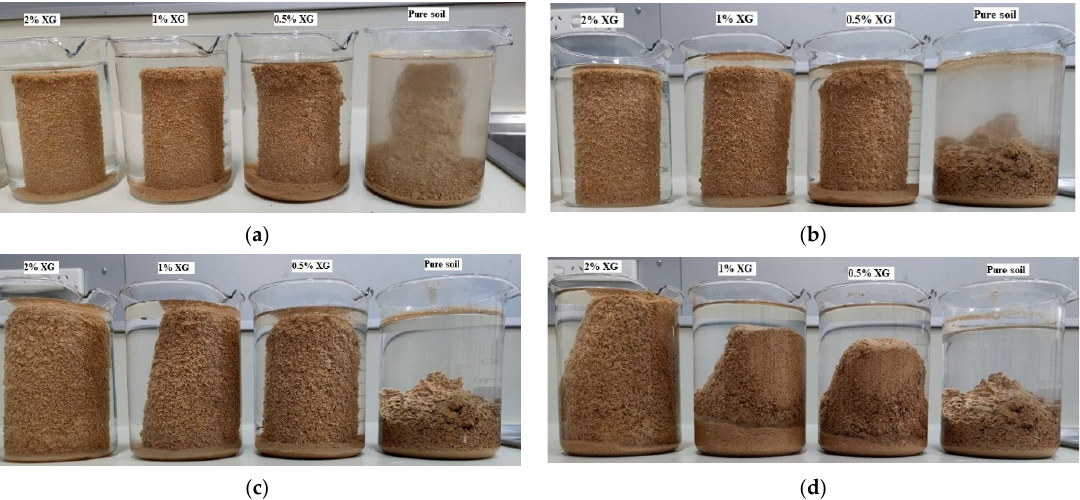
Figure 9. Variations in unconfined compressive strength of the XG-treated soil with wetting and drying cycles.